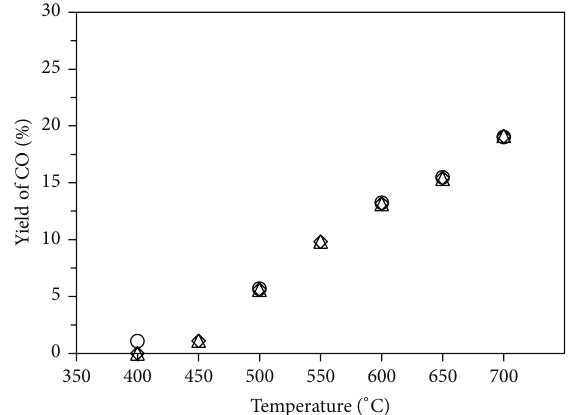
= 𝑃 = 1 kPa, balance H 2 CO 2